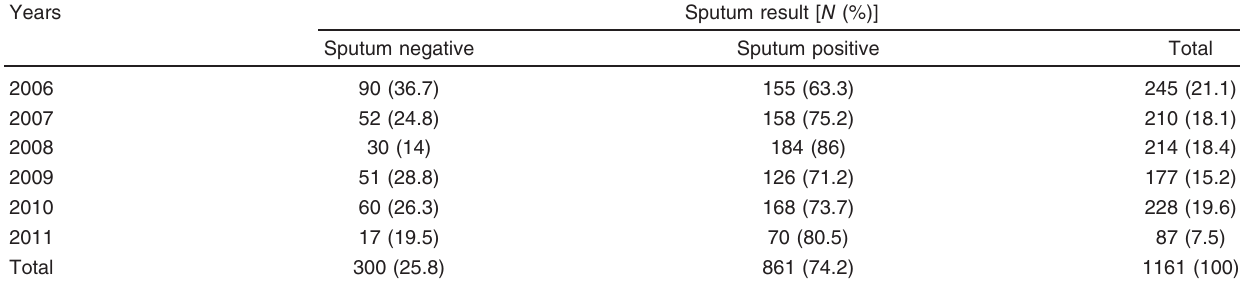
Table 5 Results of sputum smear microscopy for pulmonary cases during the period of the study